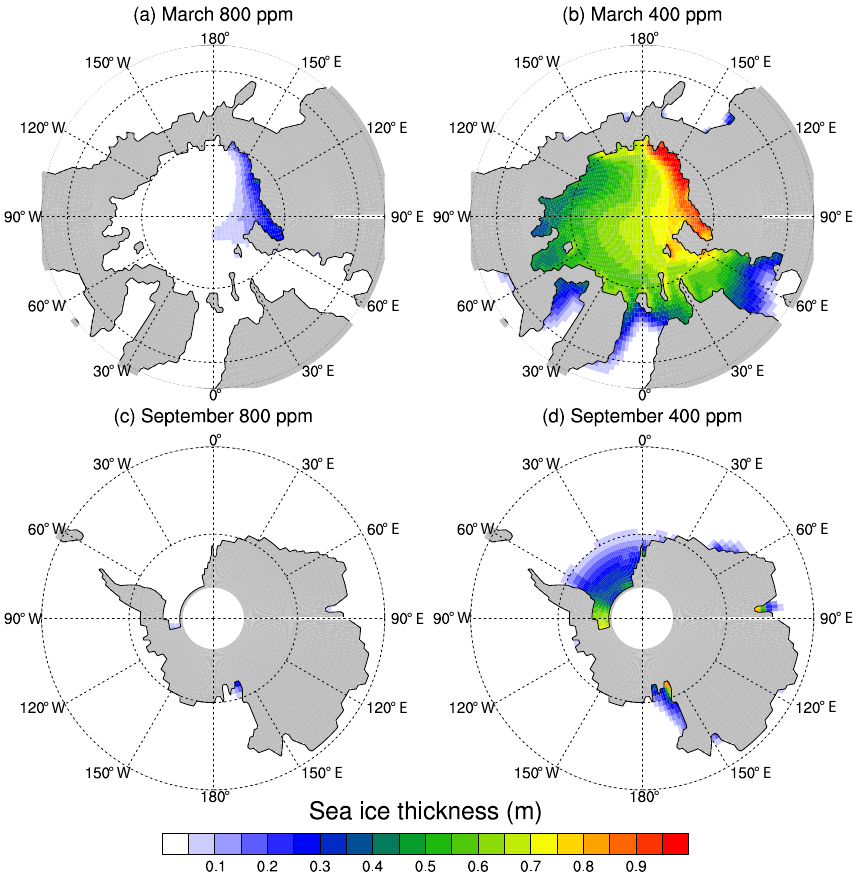
Figure 6. March (NH maximum) sea ice thickness of the 800ppm run (a) , and the 400ppm run (b) , and September (SH maximum) sea ice thickness for the 800ppm run (c) and the 400ppm run (d) . The 1600ppm run is sea ice free all